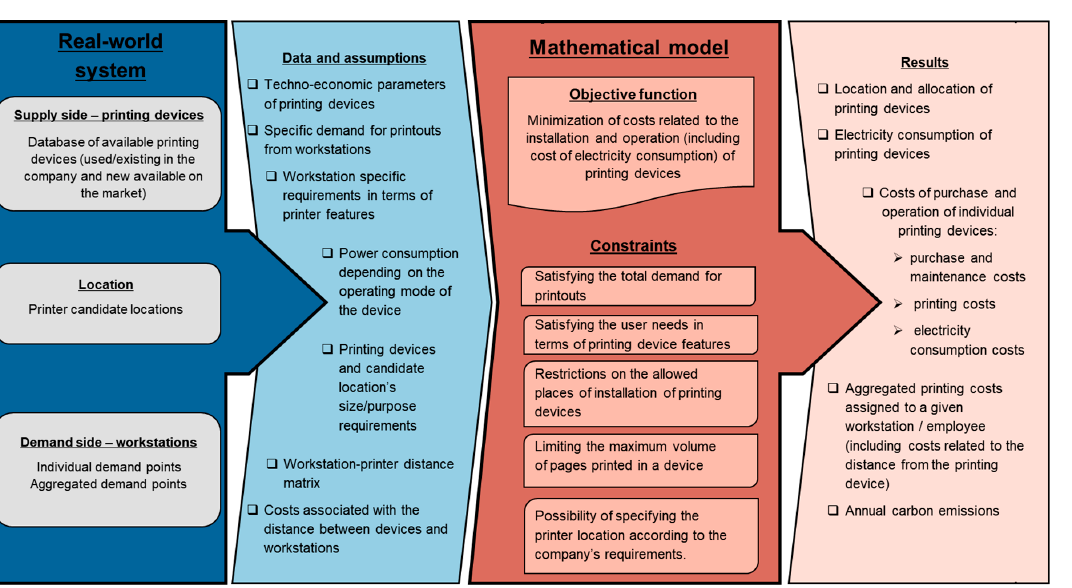
Figure 1. Scheme of the optimization framework.